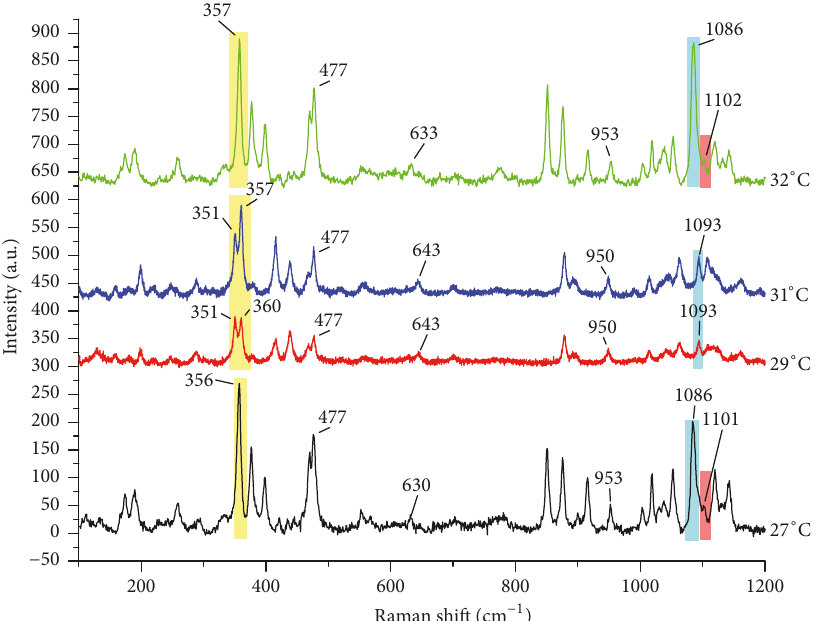
Figure 3: Raman spectra obtained for the samples prepared at the different temperatures, which is indicated on each curve. presence of a broad band at 3500 cm −1 and a weak band